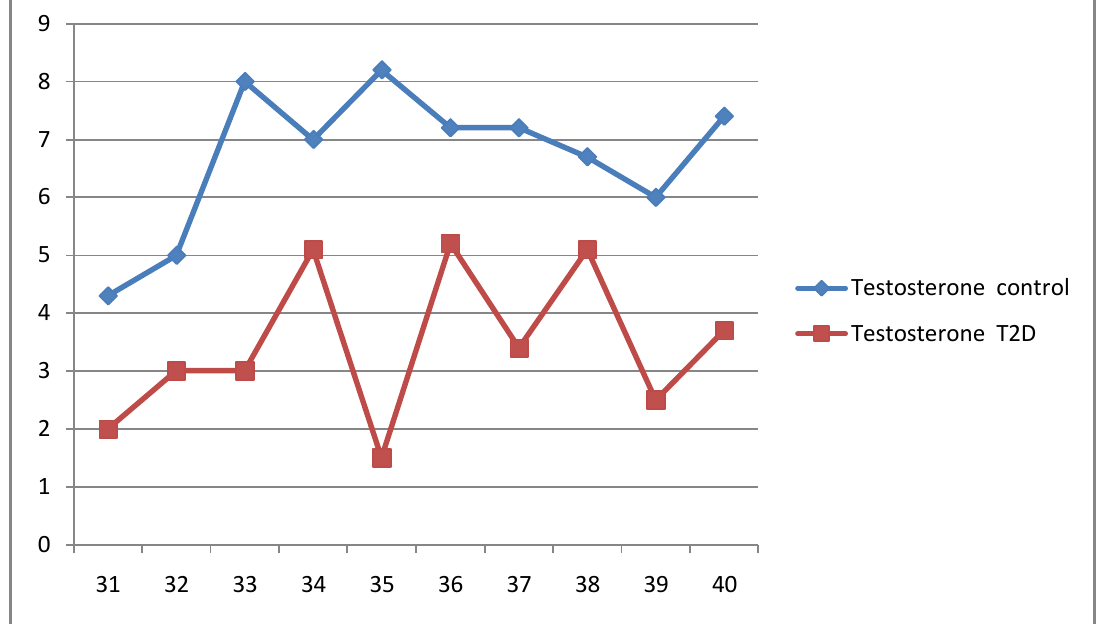
Diagram (1):Testosterone level in Group A:Showing levels of Testosterone with age in control group {above} and in T2D group {under}.